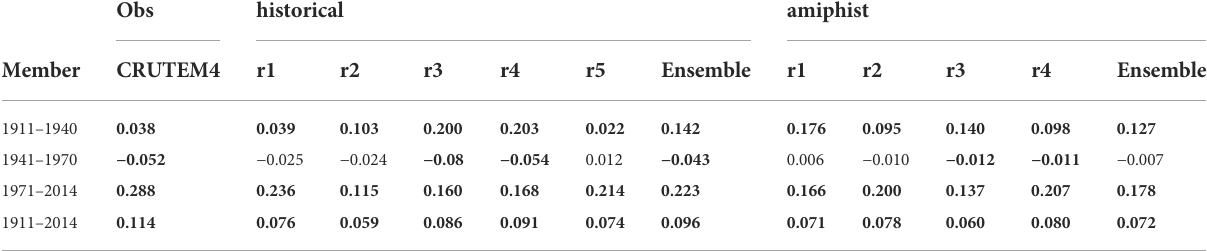
TABLE 3 Linear trend during the periods of 1911 – 1940, 1941-1970, 1971-2014 and 1911-2014 for the CRUTEM, historical and amip-hist simulations (Units: K/10 a; values in bold are signi fi cant at the 95% level).